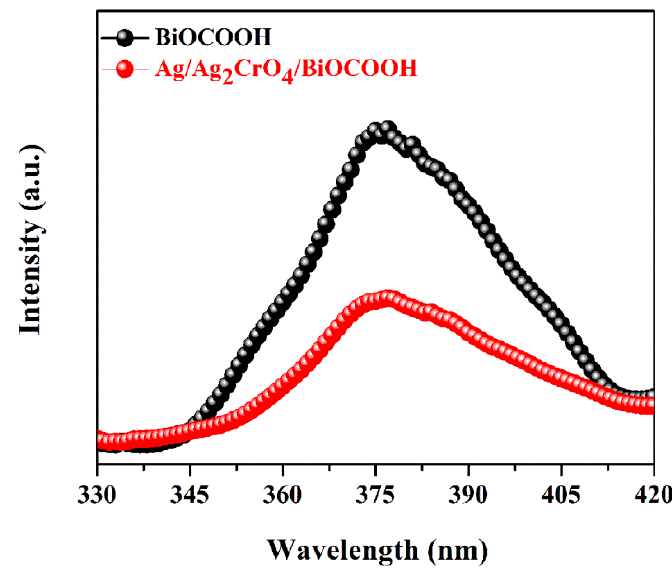
Figure 10. PL spectra of BiOCOOH, and Ag/Ag 2 CrO 4 /BiOCOOH.